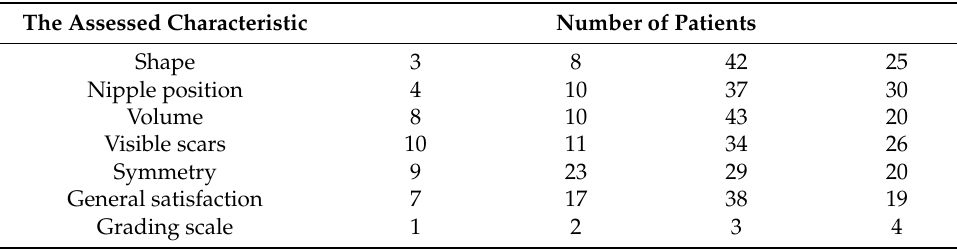
Table A1. Subjective scale of the outcomes of the operation completed by the patients just before radiotherapy.